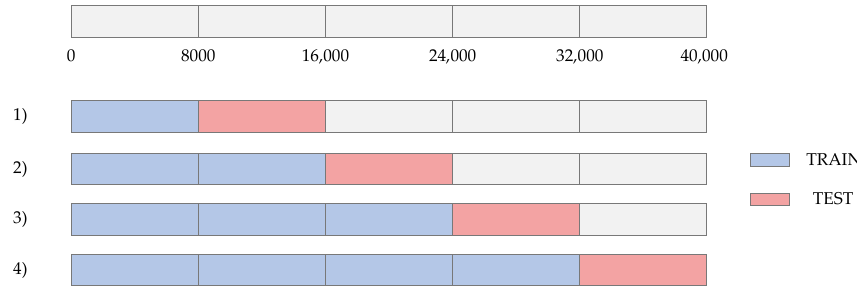
Figure 17. Four-fold moving origin cross validation strategy in the time series